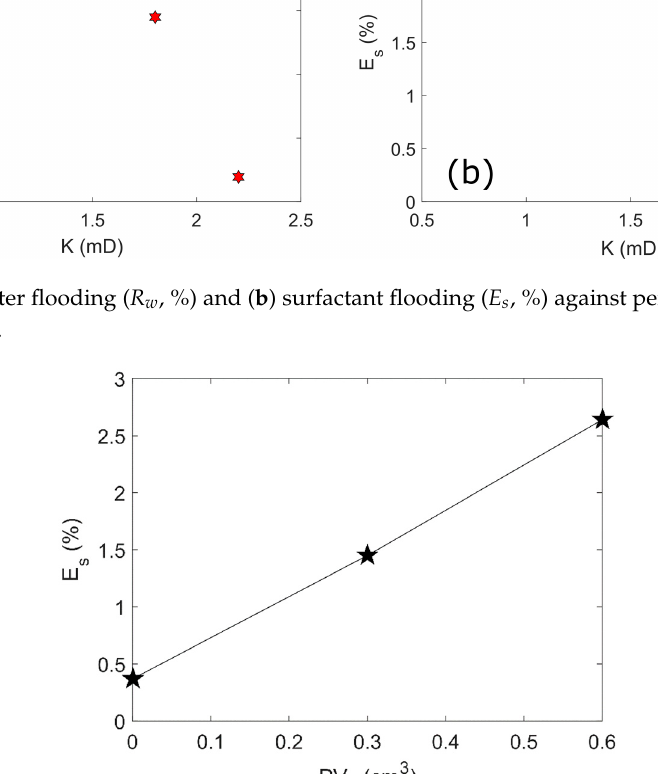
Figure 7. The hypothetical configuration of residual oil phase in ( a ) strong oil-wet core sample FD5H, and ( b ) weakly oil-wet core sample FD4H during surfactant flooding.